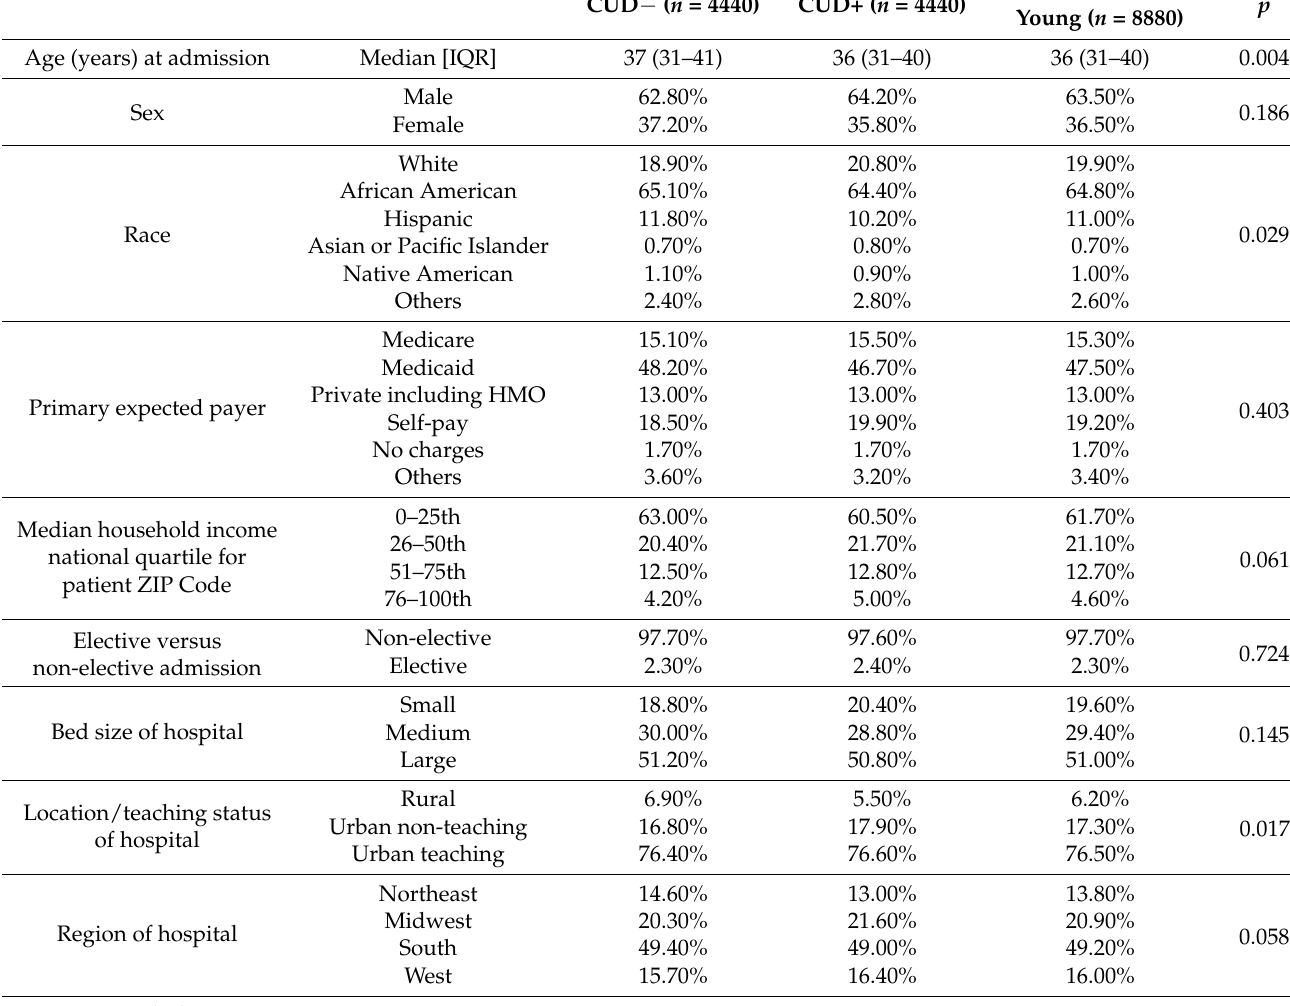
Table 3. Baseline characteristics of Propensity-score Matched Cohorts (CUD+ versus CUD − ) With Hypertensive Crisis-related